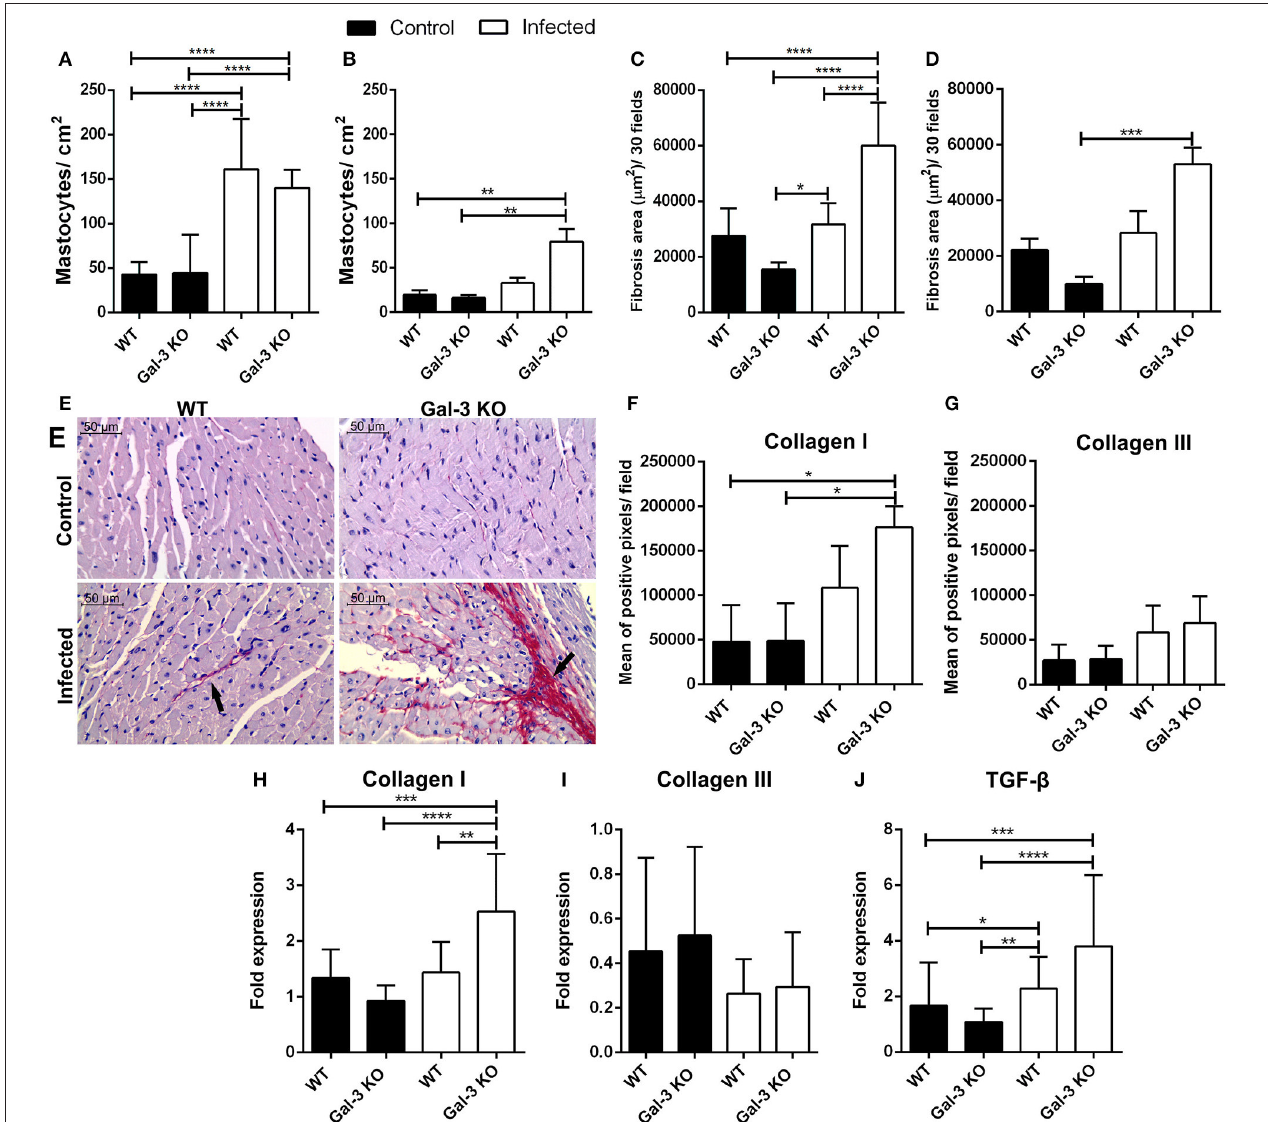
FIGURE 3 | Lack of Gal-3 leads to recruitment of mast cells and higher heart fibrosis levels during the chronic stage of T. cruzi infection. Cardiac tissue sections from WT or Gal-3 KO mice infected or not by T. cruzi CL strain trypomastigotes were stained with toluidine blue for mast cell count or picrosirius for quantification of collagen. Mastocytes recruitment during acute (15 days post infection) (A) and chronic (90 days post infection) (B) infection was count and infected Gal-3 KO mice presented higher recruitment in both phases. Augmented/increased levels of fibrosis were observed in heart sections from these animals during acute (C) and chronic (D) phases of infection. Representative histological images from heart of WT and Gal-3 KO mice infected or not by T. cruzi for 90 days (E). Red staining represents fibrosis (black arrows). Sections stained with picrosirius were analyzed under a polarized microscope for differentiation of collagen type I (F) and III (G). Collagen I (H), collagen III (I) , and TGF- β (J) RNA levels were quantified by Real-Time RT-PCR in hearts. Chronically infected mice show higher amounts of collagen type I in heart, whereas Gal-3 KO animals have higher levels compared with WT. The infection did not alter the levels of collagen type III in heart. TGF- β gene expression was increased in Gal-3 KO mice. Comparisons between groups were performed by Kruskal–Wallis and Dunn’s multiple comparisons test. * p < 0.05, ** p < 0.01, *** p < 0.001, **** p <